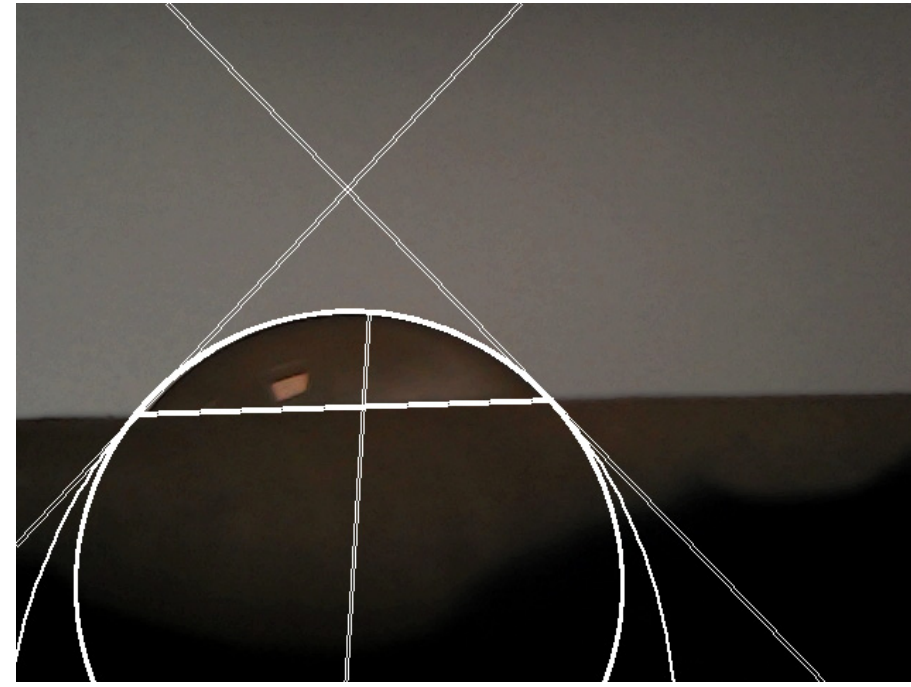
Figure 1. Contact angle measurement using Image J software.